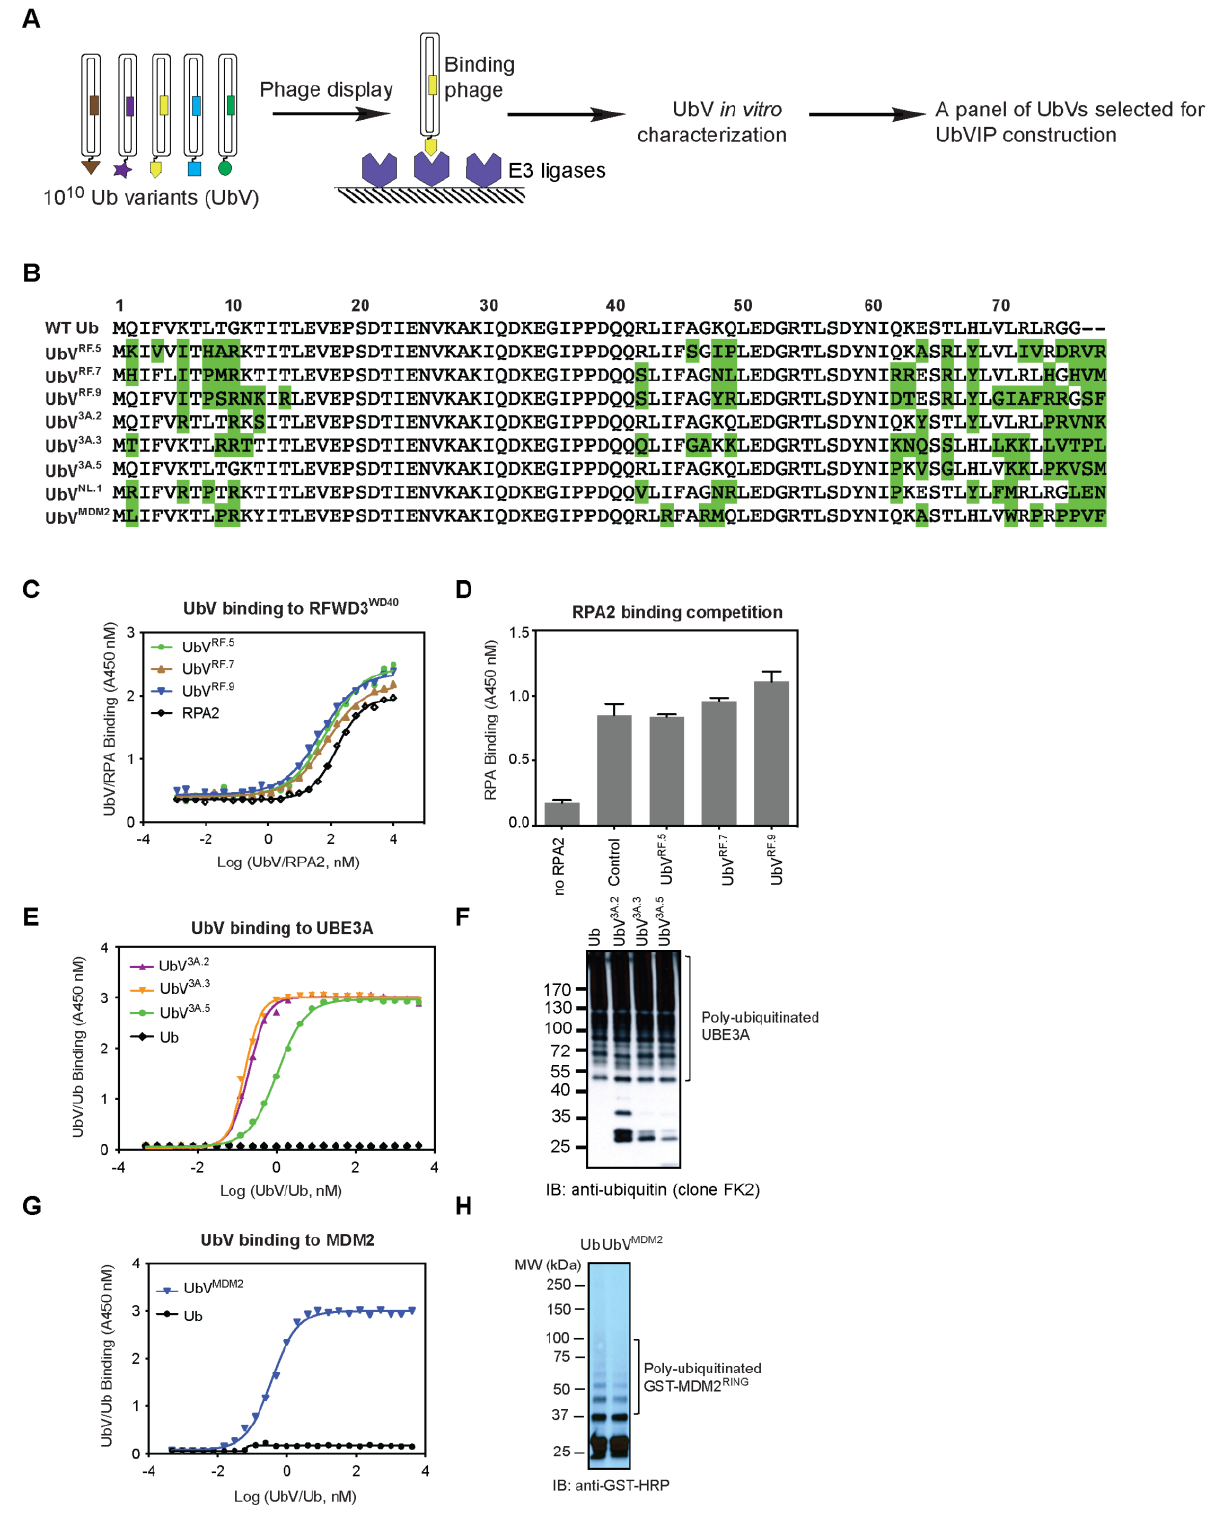
Figure 1. Development of non-inhibitory UbV binders for human E3 ligases. ( A ) Schematic repre- sentation of the UbV nomination process. Within the UbV library, each phage particle displays a unique UbV. Binding phages were captured with immobilized E3 ligases. After a total of five rounds of phage display selection, individual binding clones were subjected to sequencing. UbV binders were then characterized for their effects on known E3 ligase biological functions, and a total of six